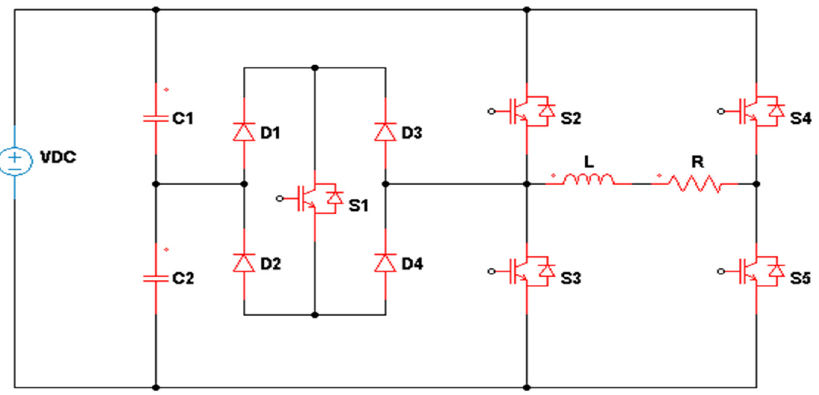
Figure 6. Five-level inverter with a bidirectional switch.